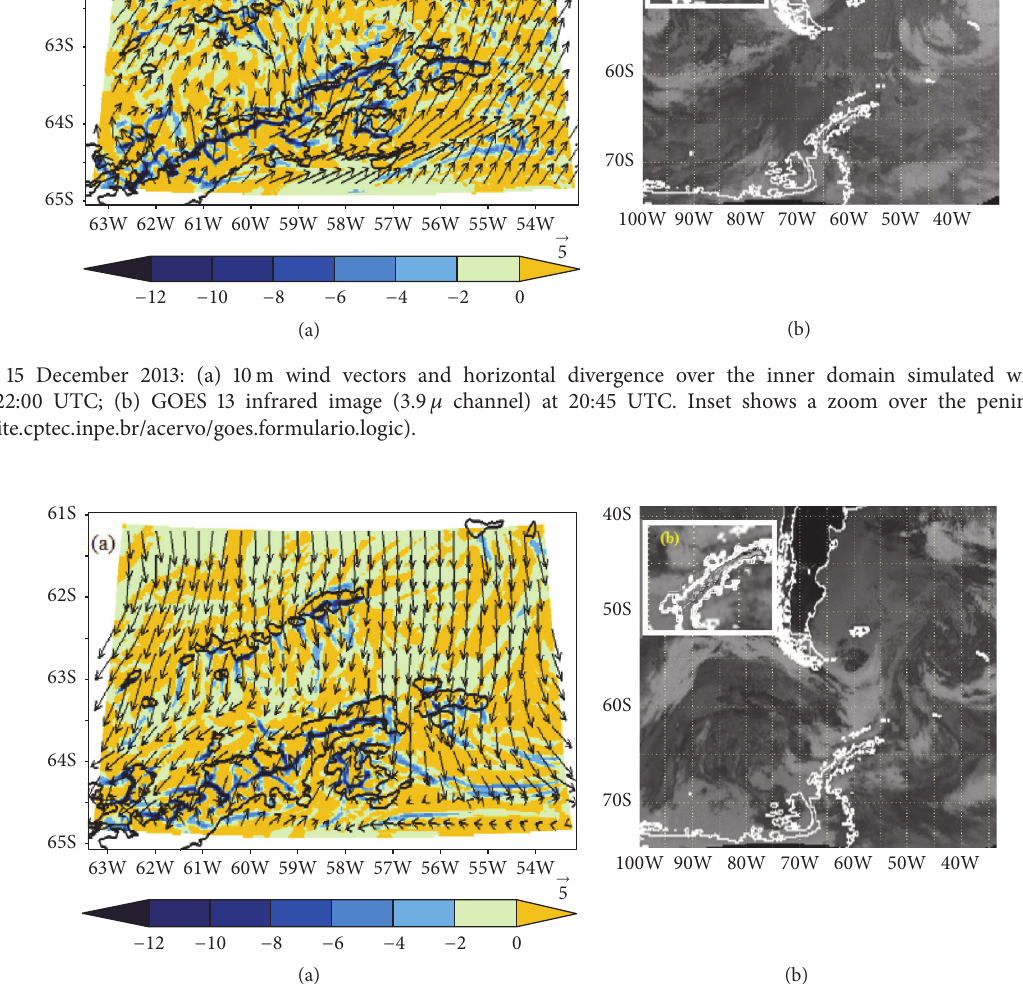
largest gradients happen when the sea breeze occurs near the coastline, especially for a mature sea breeze [32]. The present results show large horizontal temperature gradients between the peninsula and the sea (Figure 10). The development of the sea breeze circulation system extends up to 1.2 km or higher. The vertical profiles of the simulated wind and potential temperature patterns are strongly affected by the topography, which marks a region of convergence or diver- gence, during the day and night, respectively.